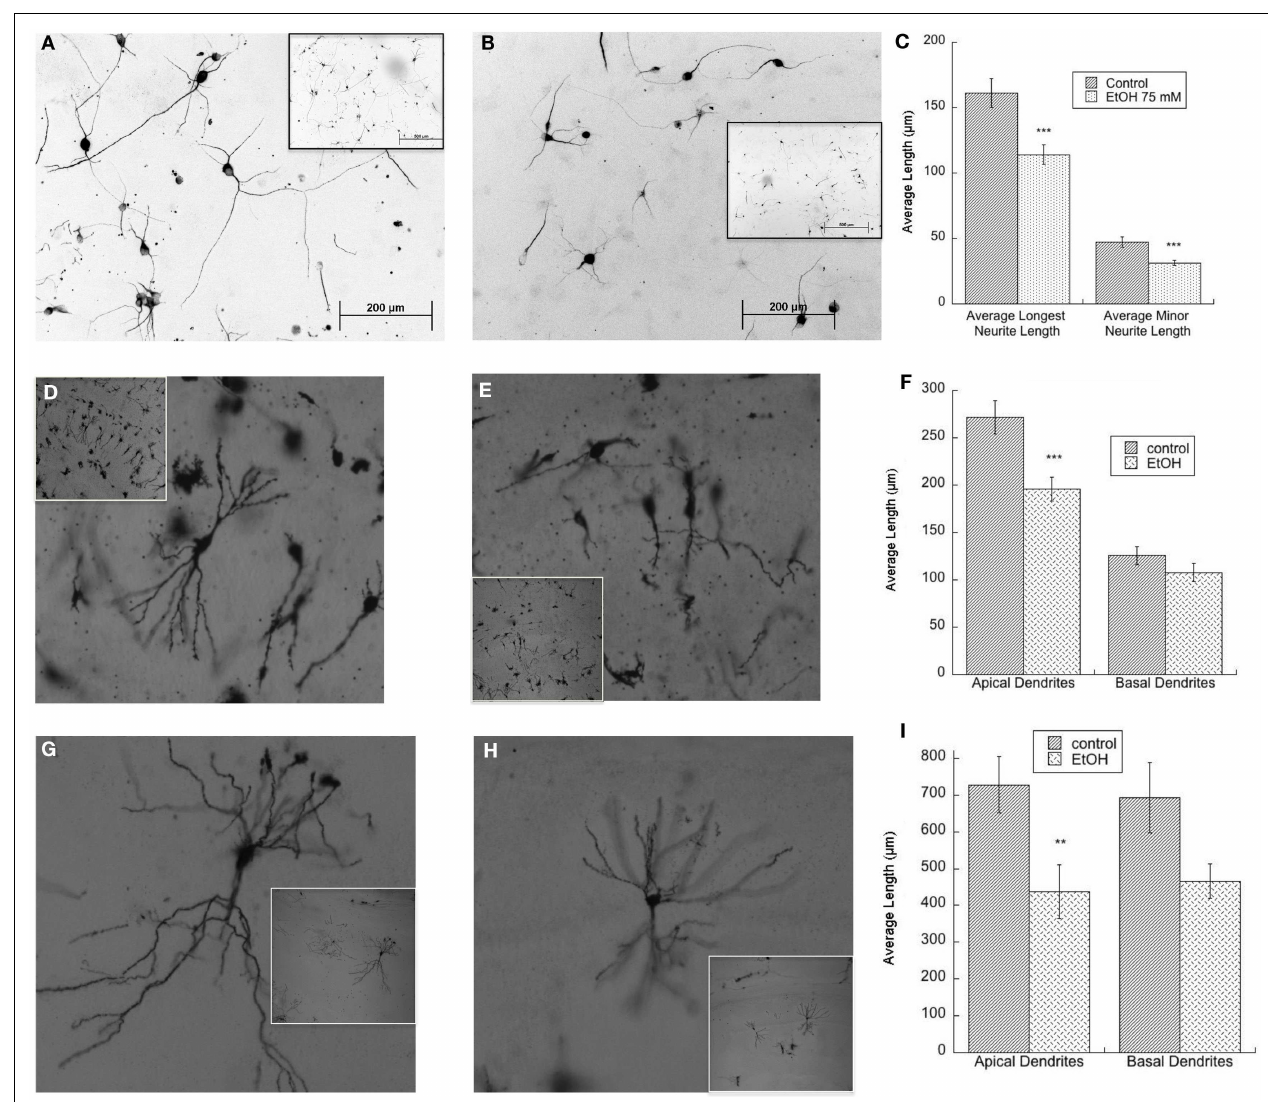
procedure. Representative CA1 neurons in control (D) and ethanol-exposed rats (E) are shown (10 × ); insets show the same fields at a lower magnification (4 × ). Dendrite length was measured using the software Neurolucida (F) . *** p < 0.001 by Student’s t test. (G–I) Neonatal ethanol exposure reduces dendrite length in PD36 rats. Female rat pups were intubated with 5g/kg/day of ethanol or were sham (control) intubated from PD4 to PD9 and sacrificed on PD36. Brains were stained using the Golgi-Cox procedure. Shown are representative CA1 hippocampal neurons in control (G) and ethanol-exposed rats (H) (10 × ); insets show the same fields at a lower magnification (4 × ). Dendrite length was measured using the software Neurolucida (I) . ** p < 0.01, Student’s t test.